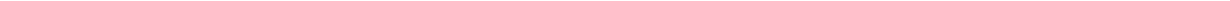
Fig. 3 Repression of acinar cell enhancers by in vivo reprogramming. a Microarray analysis in the pancreas of C-OSKM mice given Dox for 3 days. b A qRT- PCR for acinar cell-related genes and ADM-related genes after Dox treatment for 24 h in the pancreas of C-OSKM mice. Data are presented as the mean of technical triplicates. The mean expression level of wild-type samples was set to 1 for Amy , Mist1 , Ptf1a , and CK19 . For Tff1 and Muc5ac , the mean expression level of Dox 24 h samples was set to 1. c ChIP-seq analysis for H3K27ac in the pancreas of C-OSKM mice. Note that H3K27ac deposition is substantially reduced at acinar cell-related transcription factors ( Ptf1a and Mist1 ). d Super enhancers (SEs) in the pancreas of C-OSKM mice. Note that Dox OFF-speci fi c SEs show signi fi cant reduction in H3K27ac deposition in Dox ON pancreas. The number of SEs is decreased after Dox treatment for 3 days. e Dox OFF- speci fi c SE-related gene expressions are signi fi cantly suppressed by OSKM induction. *** p < 0.001, Mann – Whiteney U -test. f Forced expression of an acinar cell-related transcription factor ( Ptf1a or Mist1 ) inhibits OSKM -induced ADM formation. EGFP expression represents the expression of either Ptf1a or Mist1 . Note that most EGFP-expressing cells are negative for CK19 while the control EGFP-expressing cells often costained with CK19. Scale bars, 50 μ m. The ratio of CK19-positive cells in EGFP-positive cells of 10 independent images are shown in a box-and-whisker plot. Solid lines in each box indicate the median. Bottom and top of the box are lower and upper quartiles, respectively. Whiskers extend to ±1.5 interquartile range (IQR). *** p < 0.001, Mann – Whiteney U -test. g Super enhancers (SEs) in caerulein-treated pancreas. Note that caerulein treatment causes reduction in H3K27ac deposition at SEs that are repressed by OSKM